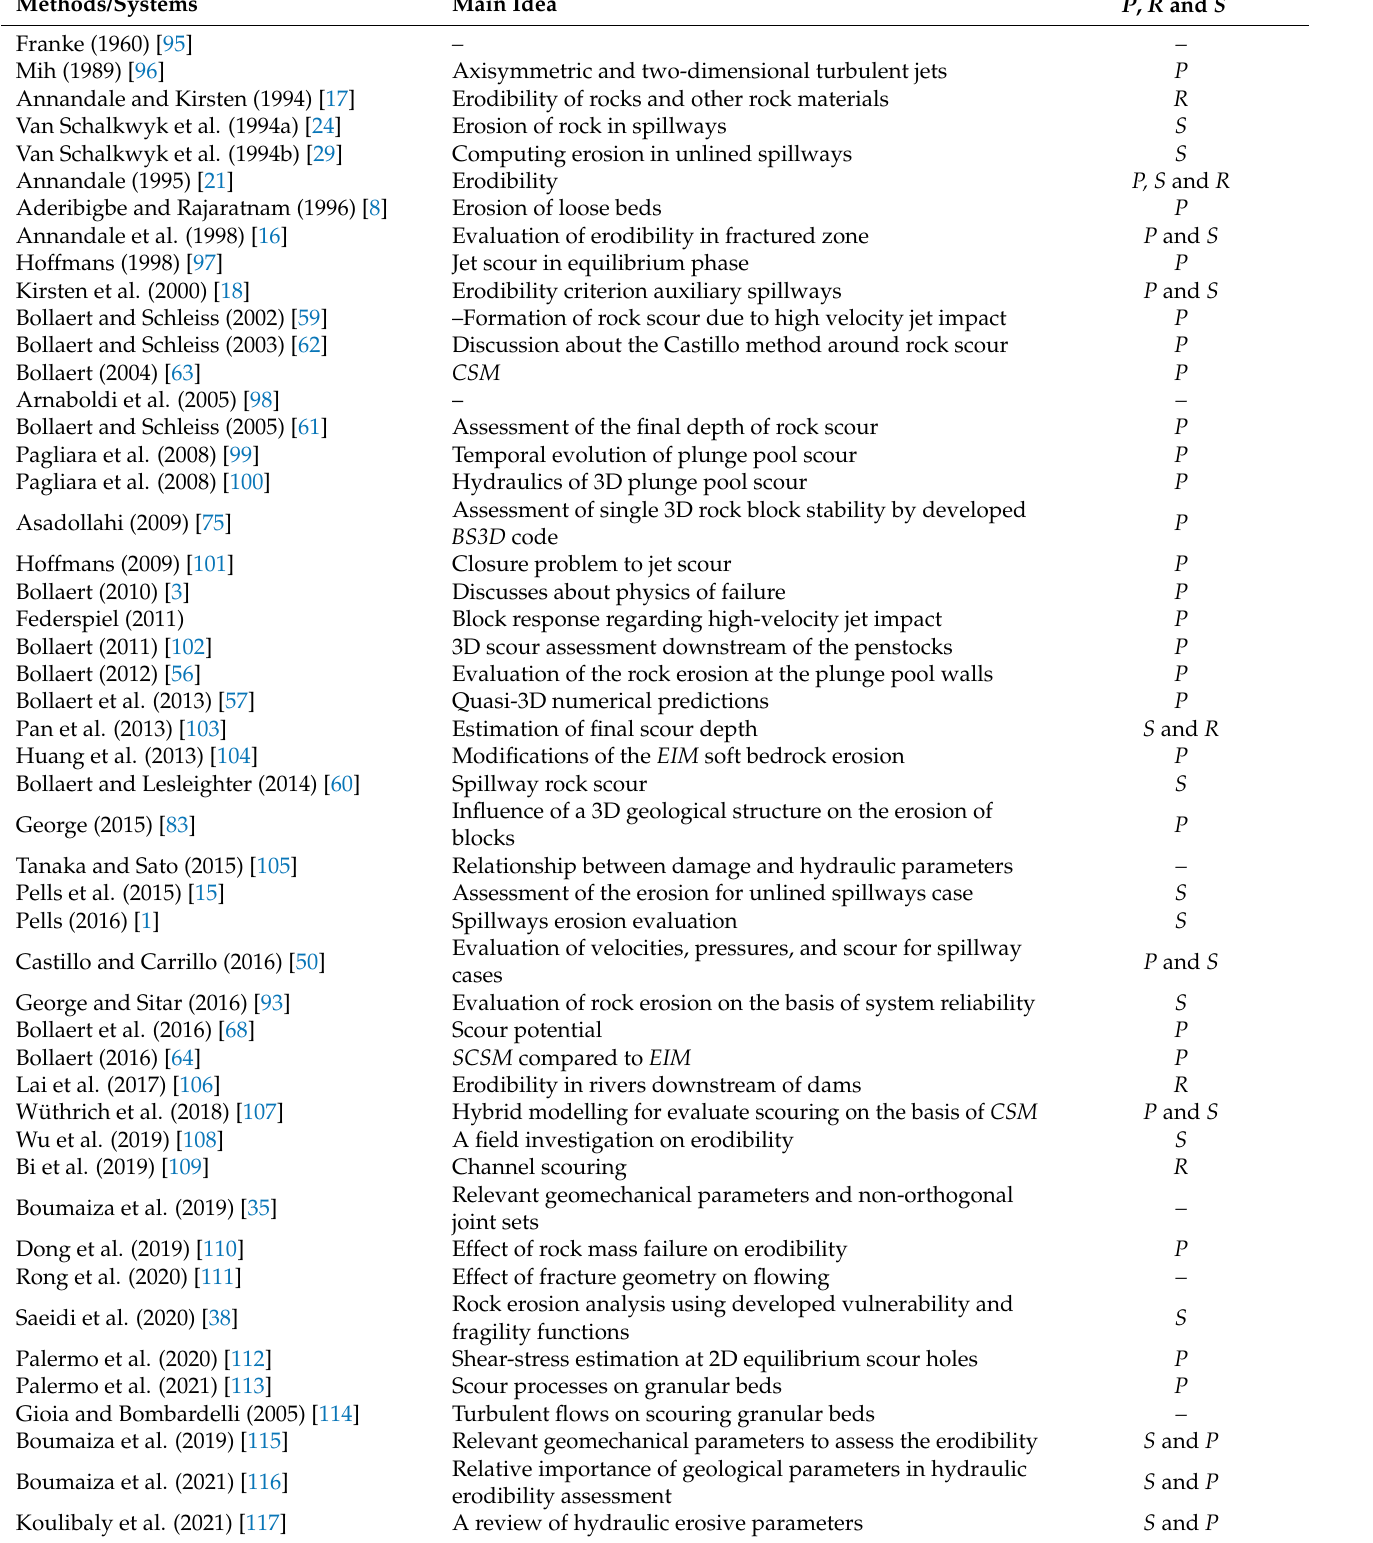
Table 15. Detailed information references about erosion or scour in spillways, plunge pools, rivers, and gullies.